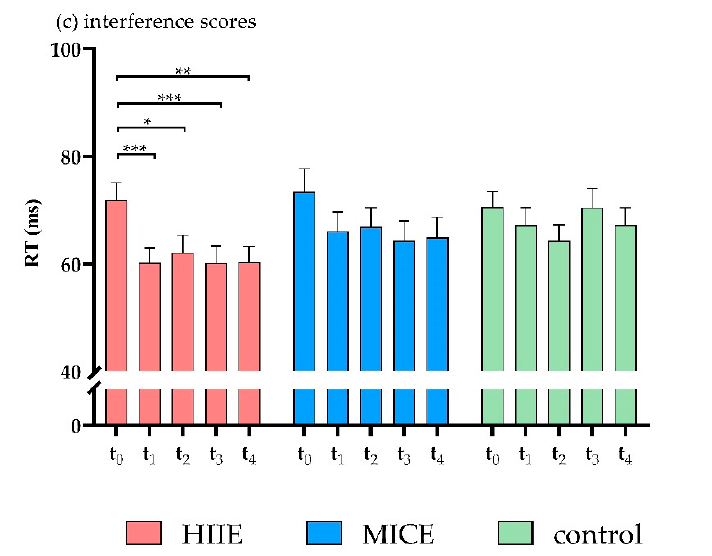
Figure 3. RTs for congruent trials ( a ), incongruent trials ( b ), and interference scores ( c ) of the flanker task. (* p < 0.05, ** p < 0.01, *** p < 0.001).